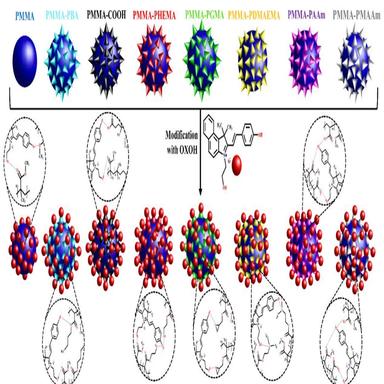
The proposed schematical mechanism for the stability and solvatochromism of the OXOH molecule by hydrogen bonding interactions with functional groups of the polymer nanoparticles.